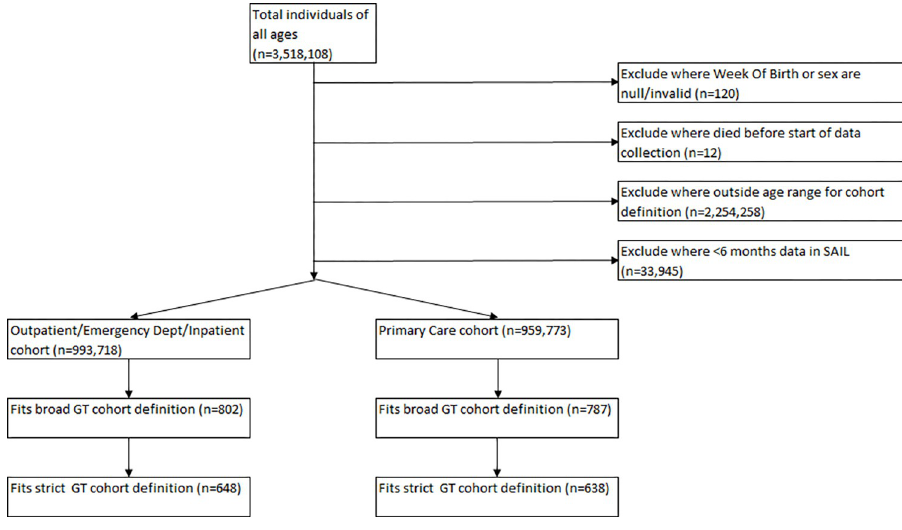
Fig 1. CONSORT diagram of study